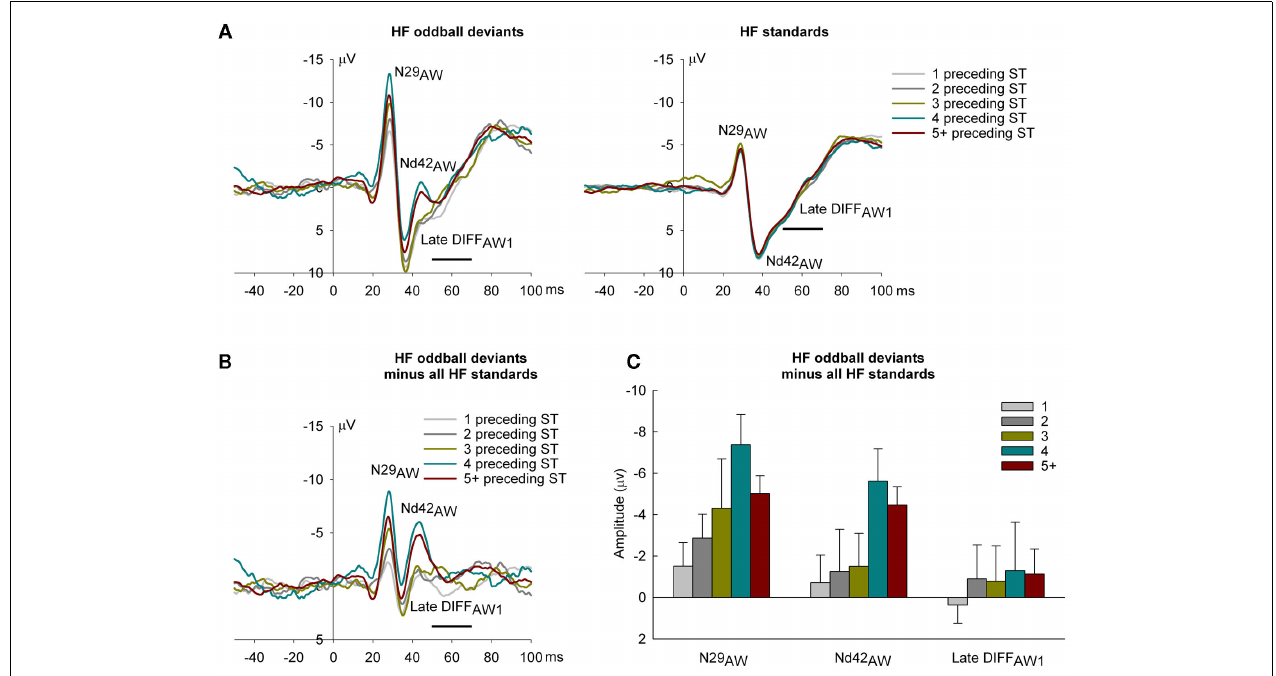
deviants) to demonstrate the effect of the number of preceding standards on N29 AW , Nd42 AW , and late DIFF AW1 . (C) The mean amplitude (with SE) of N29 AW ,